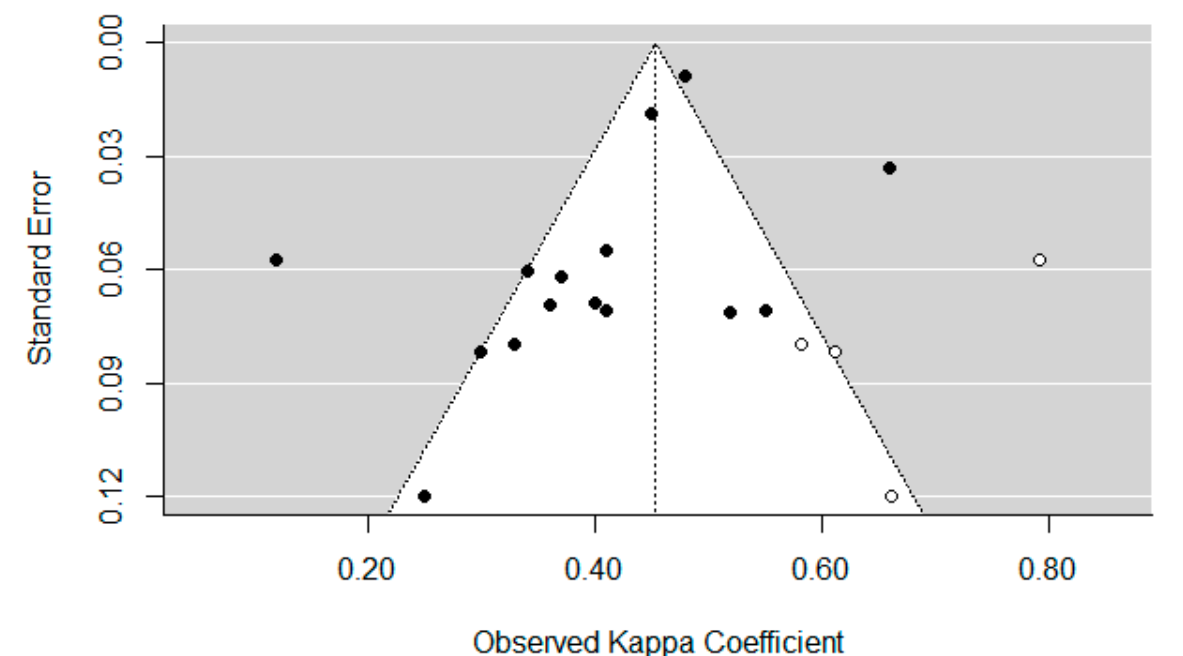
Figure 5. Forest Plot. Figure 5. Trim and fill funnel plot. White dots indicate implied missing